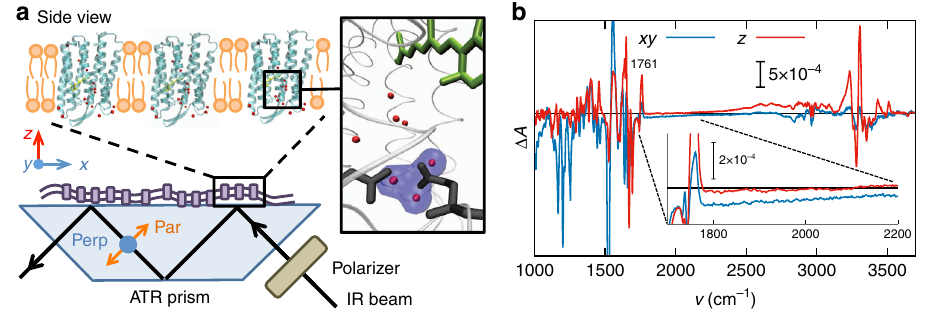
Fig. 2 Experimental polarization-resolved spectra. a In the experimental set-up, the purple membranes are oriented in the xy plane and the proton pumping direction is along z . The black arrow indicates the direction of the probing IR light, which is polarized parallel or perpendicular with respect to the plane of incidence. The inset shows a zoom-in of the crystal structure of bacteriorhodopsin 70 , with three water molecules highlighted in blue, which presumably cause the continuum band 22, 25 . b Experimental IR light-minus-dark difference spectra calculated along the xy and z directions over the whole measured range between 1000 and 3800cm − 1 . In the inset, the enlarged difference absorption spectra in the relevant wavenumber range 1700 – 2200 cm − 1 are shown together with the (positive) band at 1761 cm − 1 of the C = O stretching vibration